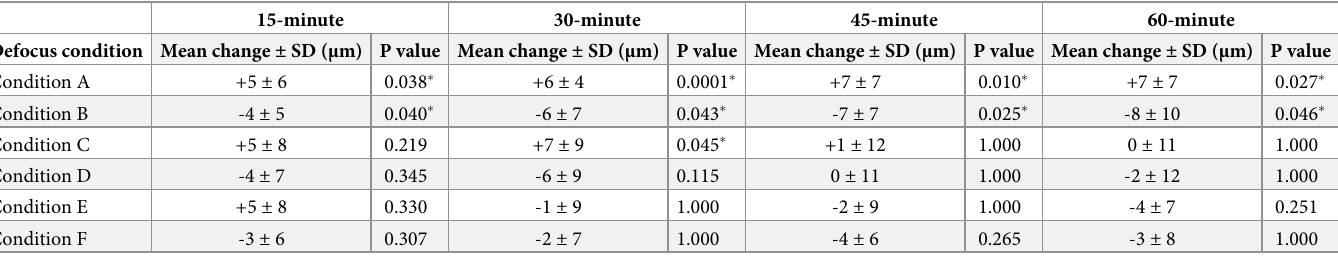
Table 1. Mean change in axial length from baseline across different measurement times for continuous and alternating defocus conditions in all subjects.